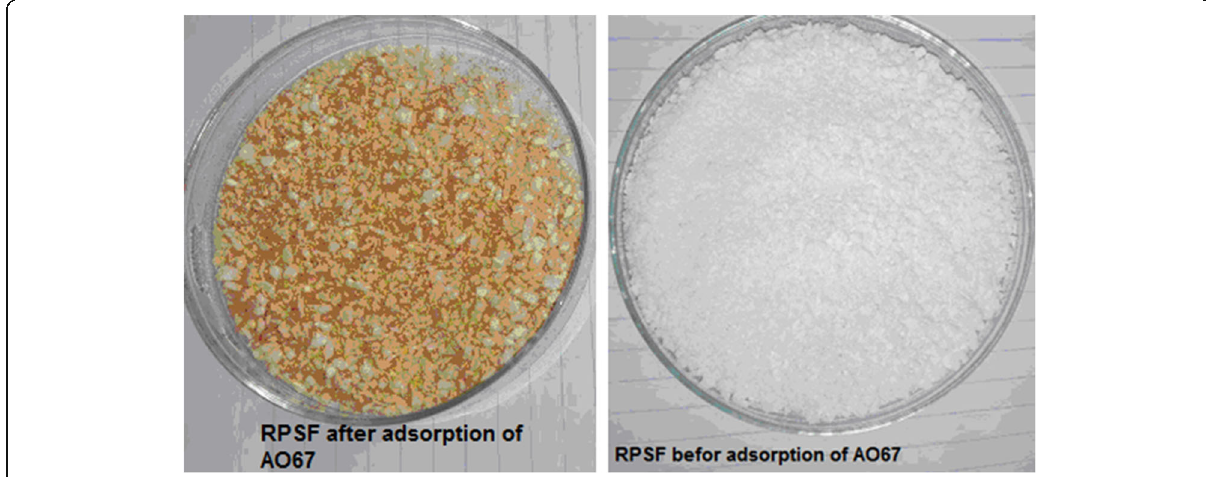
Fig. 1 Showing the Synthetic resins from waste foam